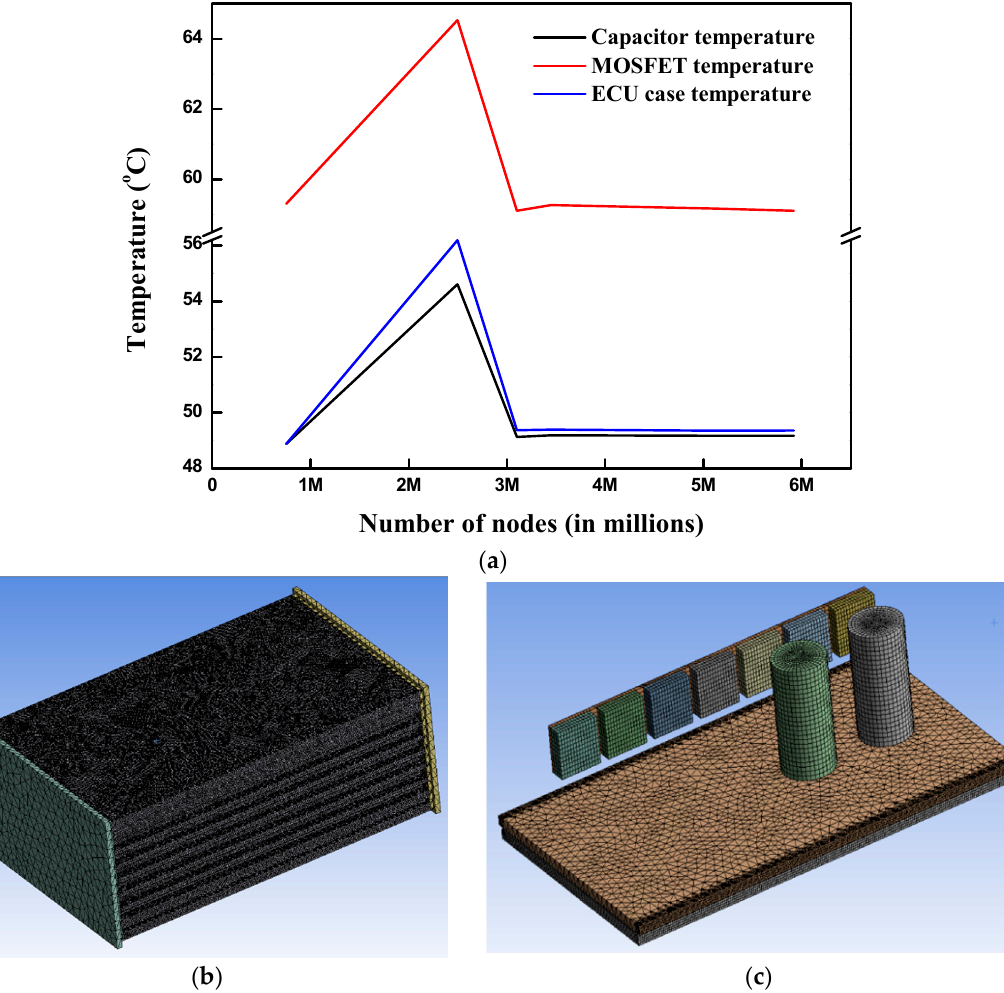
Figure 4. Meshing details of the 36V ECU: ( a ) Variation of the maximum temperature of the capacitor, metal-oxide-silicon field effect transistor (MOSFET) and the ECU case with the number of grids; ( b ) Meshing details for the ECU outer case; ( c ) Meshing details for the ECU major components including printed circuit board (PCB), capacitors and MOSFETs.